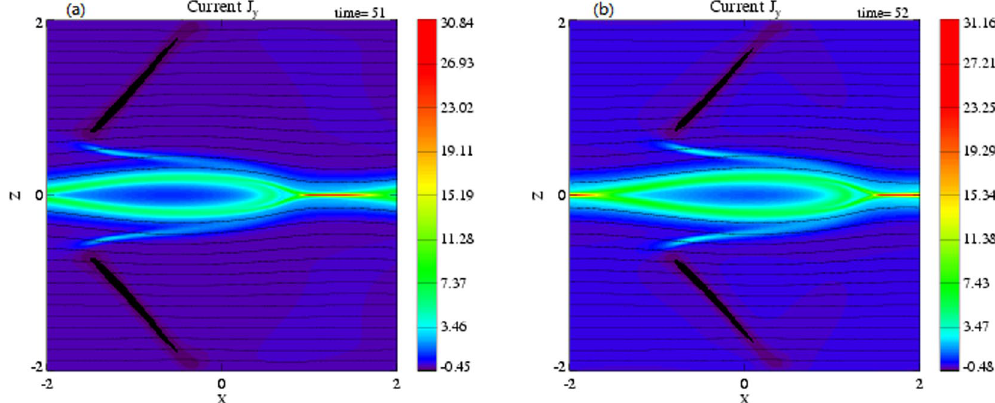
Figure 2. Color contours of the current density (J y ) with magnetic field lines (black solid lines) at ( a ) t = 51 and ( b ) t = 52.